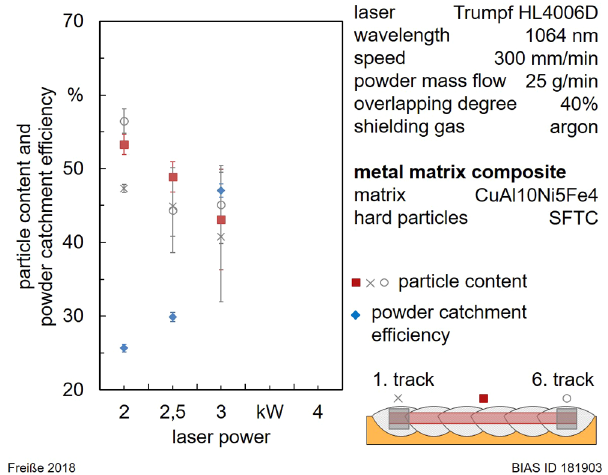
Fig. 9. Variation of laser power in laser melt-injected multi- tracks showing a decrease of the particle content and an increase of the powder catchment ef fi ciency.